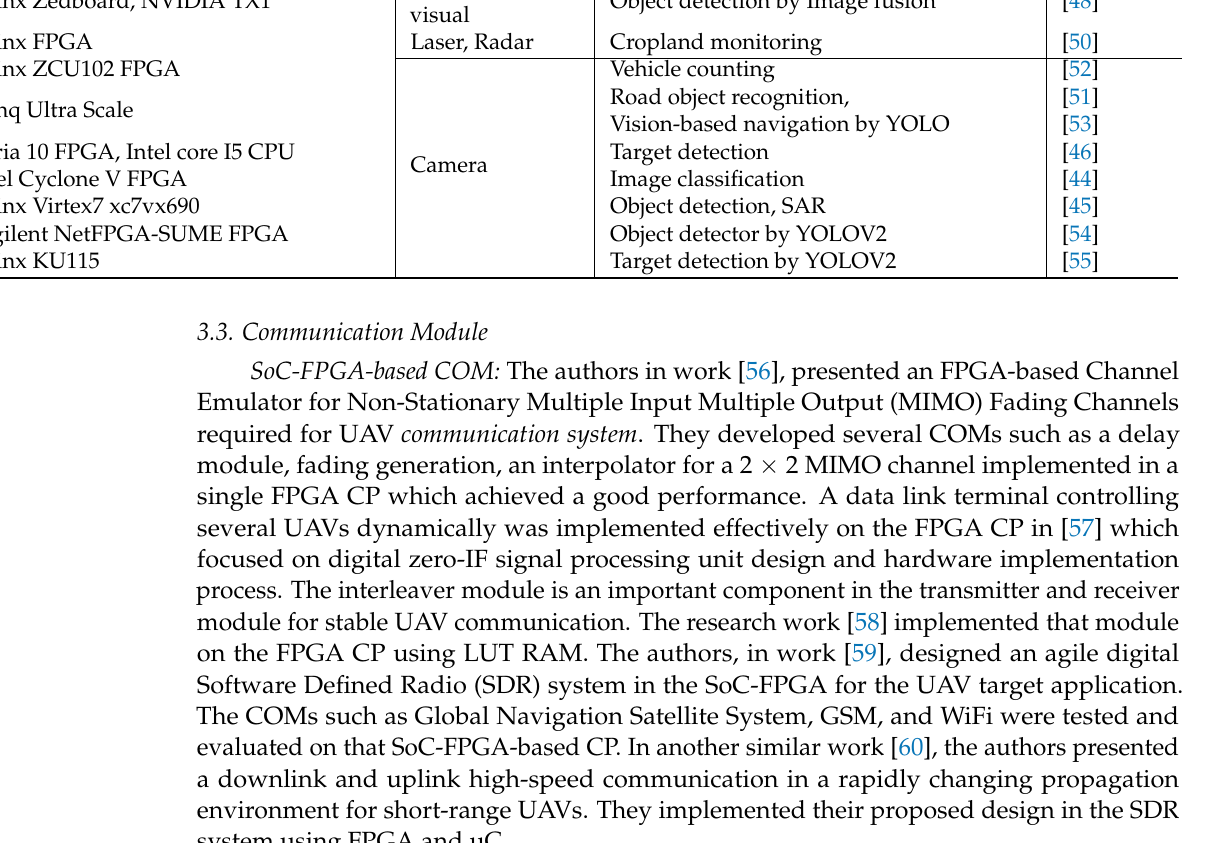
Table 5 represents several CPs used for COMs for the